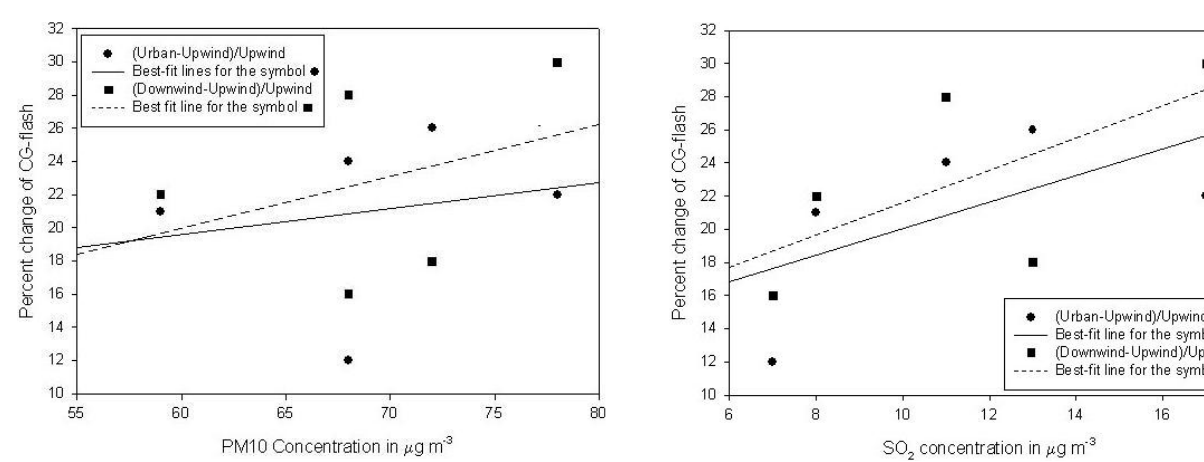
Fig. 6. Scatter plot and best-fit line of percent change in the number of CG flashes and annual averages of SO 2 concentrations for the years